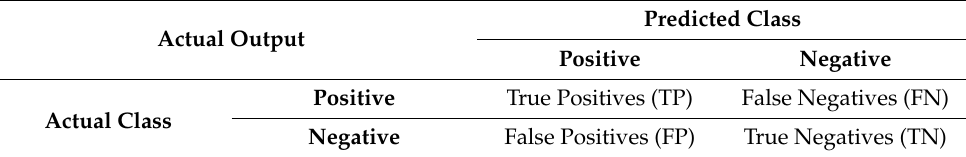
Table 2. Confusion